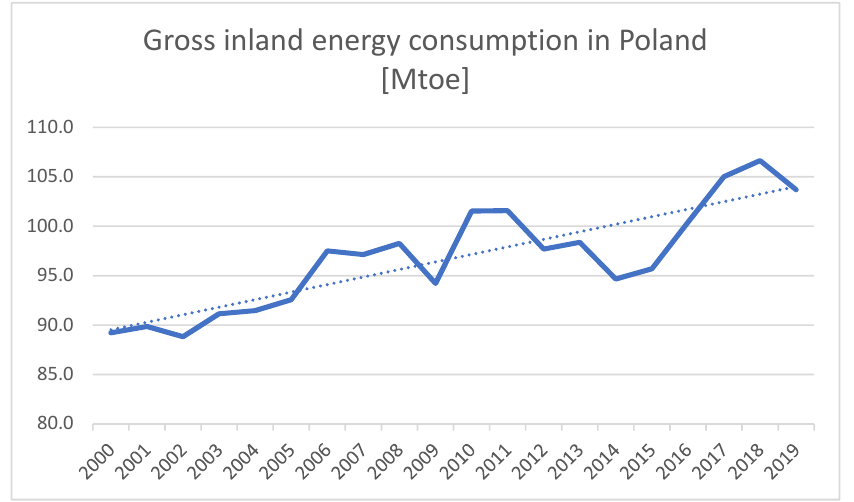
Figure 3. Gross inland consumption in Poland [Mtoe]. Source: Authors’ elaboration based on EU energy figures in Statistical Pocketbook 2019.